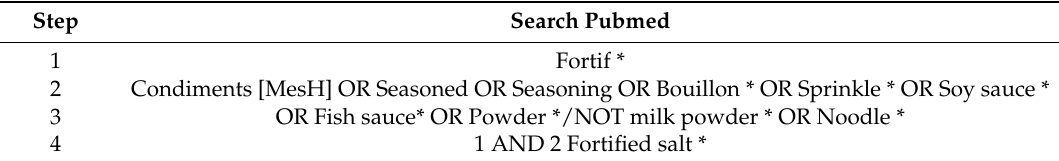
Table 1. Pubmed electronic search